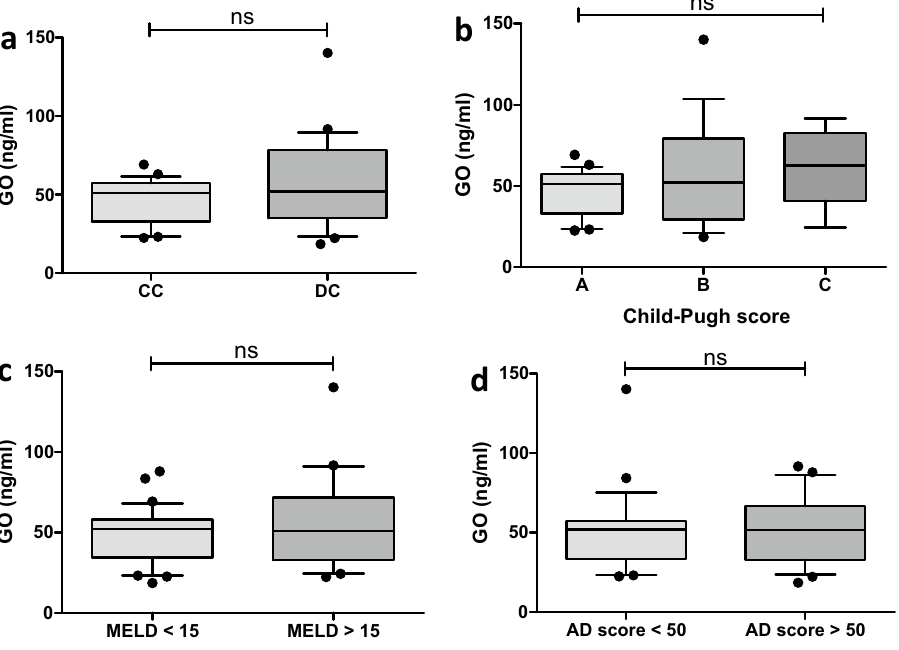
Figure 4. Whisker boxplots showing median (IQR 10th; 90th) GO serum levels in patients with different liver disease severities. ( a ) The GO levels were not higher in patients with decompensated cirrhosis (DC). ( b ) Patients with a Child–Pugh score of C did not show higher levels than patients with Child–Pugh A and B patients. ( c ) A MELD score ≥ 15 did not increase the GO serum levels. ( d ) The acute decompensation (AD) score was not significantly different between the two groups. Differences between two groups were analyzed using the Mann– Whitney U test. More than two groups were analyzed by the Kruskal–Wallis test. The dots refer to values beyond the range of the 10th and 90th percentiles. ns not significant.